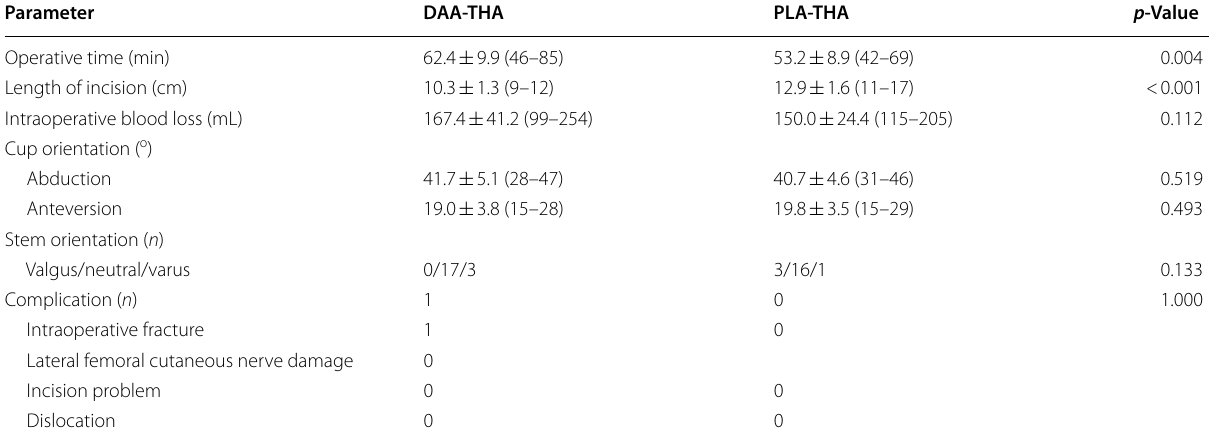
Table 2 Intraoperative data, prosthesis position, and complications in the two groups